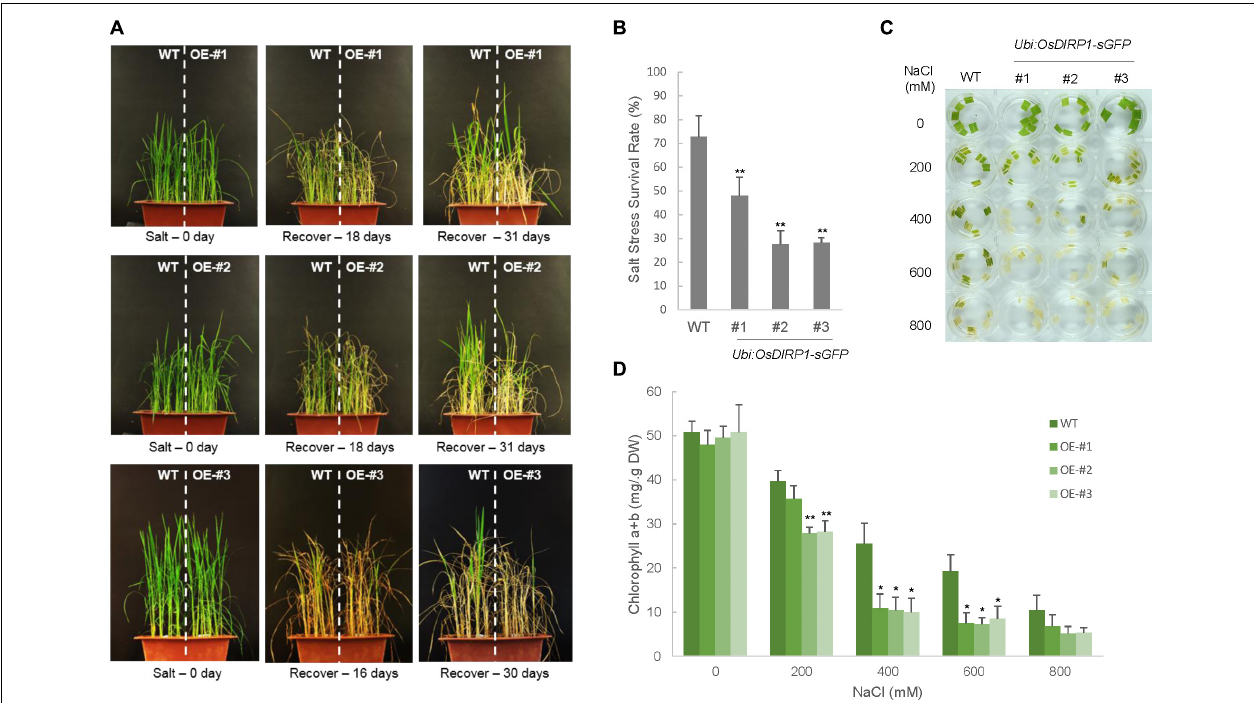
FIGURE 4 | Decreased tolerance of Ubi:OsDIRP1-sGFP transgenic rice plants in response to salt stress. (A) The salt stress phenotypes of wild-type and T4 Ubi:OsDIRP1-sGFP plants. Light-grown, 5-week-old wild-type and T4 Ubi:OsDIRP1-sGFP (lines #1, #2, and #3) plants were treated with 200 mM NaCl for 16–18 days and then transferred to normal growth conditions with watering for 1 month. OE represents OsDIRP1 -overexpressing transgenic rice plants. (B) Survival rates of wild-type (WT) and T4 Ubi:OsDIRP1-sGFP plants in response to salt stress. Data are means ± SE ( n ≥ 5 independent biological experiments; > 40 plants were used in each assay, ∗ P < 0.05, ∗∗ P < 0.01, Student’s t -test). (C) Leaf disk senescence assays in response to high salinity. Leaf disks (0.5 cm in diameter) were prepared from 5-week-old wild-type and transgenic plants and floated in different concentrations (0, 200, 400, 600, and 800 mM) of NaCl for 3 days. A representative photo was taken after 3 days of incubation. (D) Chlorophyll content in the leaf disk senescence assay. The amounts of chlorophyll (chlorophyll a + chlorophyll b) in the wild-type and T4 Ubi:OsDIRP1-sGFP (lines #1, #2, and #3) leaf disks were determined 3 days after incubation with different concentrations (0, 200, 400, 600, and 800 mM) of NaCl. Data are means ± SE ( n ≥ 4 independent biological experiments, ∗∗ P < 0.01, Student’s t